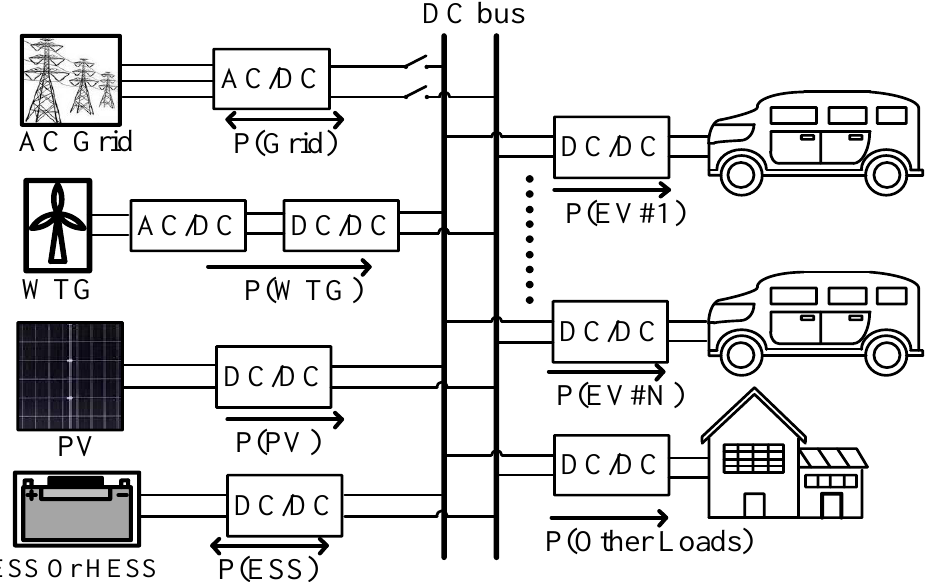
Figure 8. Typical system configuration of a grid-connected ECS with ESS and RE power generation.